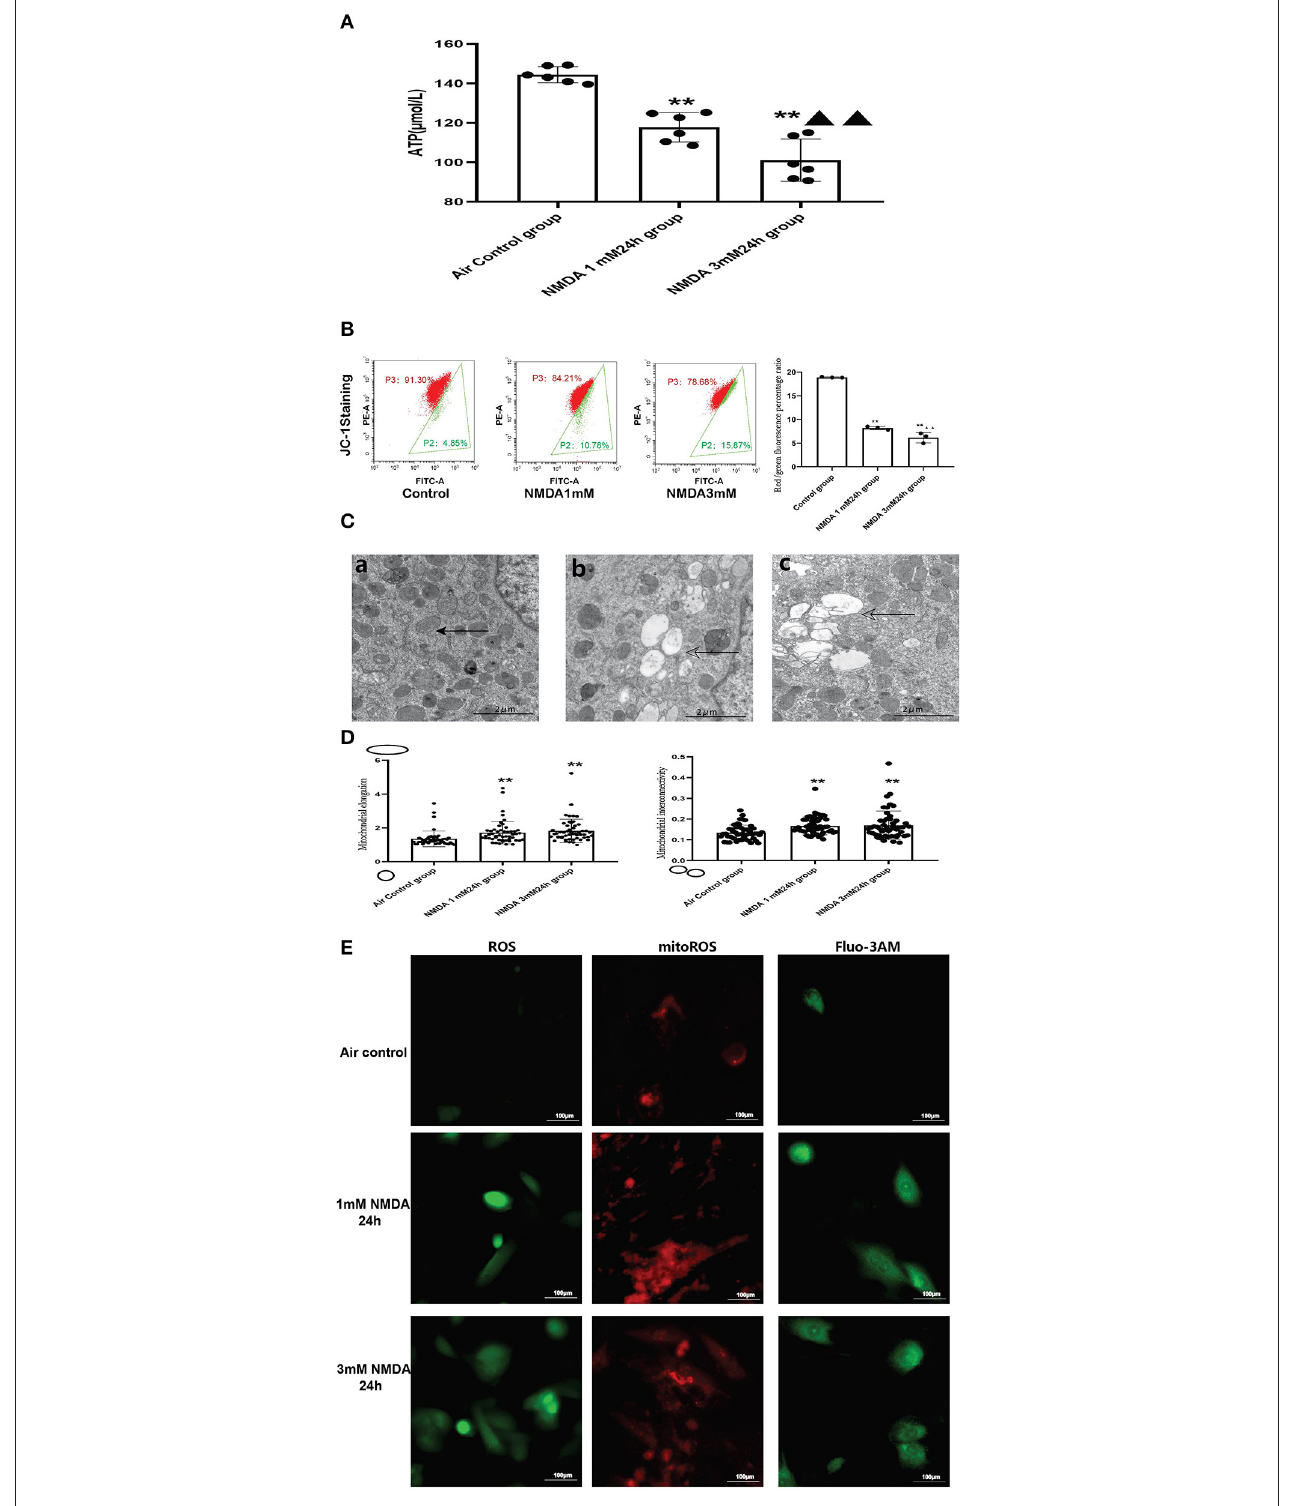
FIGURE 7 | Excessive activation of NMDAR aggravated mitochondrial function. (A) Effects of NMDA exposure in ATP production ( N = 6); (B) Effects of NMDA exposure in mitochondrial membrane potential; (C) Effects of NMDA exposure in mitochondrial ultrastructural damage (5000x), solid arrows: normal mitochondria; hollowed arrows: damaged mitochondria; (a): control group; (b): NMDA1mM group; (c): NMDA3mM group. (D) Effects of NMDA exposure in mitochondrial elongation (left) and interconnectivity (right); (E) Effects of NMDA exposure in ROS, mitoROS and intracellular calcium levels (400x); Compared with the air control group: * P < 0.05, ** P < 0.01; compared with the NMDA 1 mM 24 h group: △ P < 0.05, △△ P < 0.01. All data are presented as mean ± S.E.M.